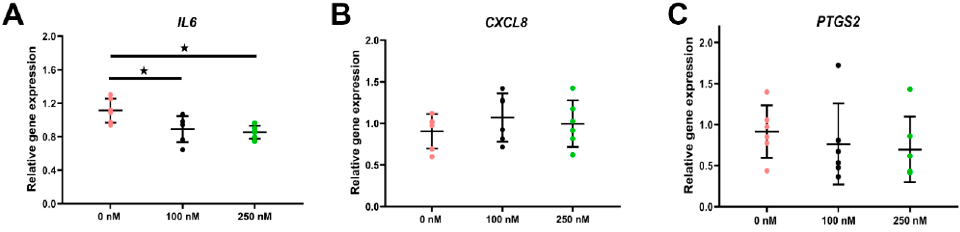
Figure 4. Effect of cortisol on inflammatory marker gene expression in ALI-POEC. Relative mRNA abundanceof( A ) IL6 , ( B )C-X-Cmotifchemokineligand8( CXCL8 ), and( C )prostaglandin-endoperoxide synthase 2 ( PTGS2 ). Data are shown as mean with SD. Asterisks indicate a significant di ff erence at p < 0.05. n = six